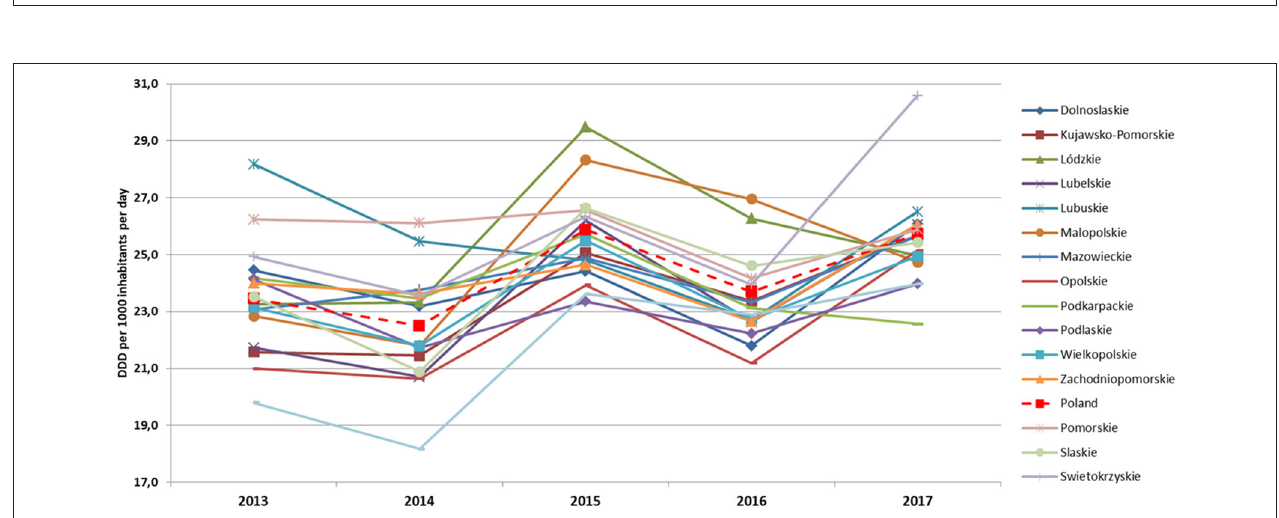
FIGURE 1 | The structure of consumption of antibacterials for systemic use (J01) by subgroups in primary care in Poland (2013–2017, defined daily doses, DDD, per 1,000 inhabitants per day, DID).